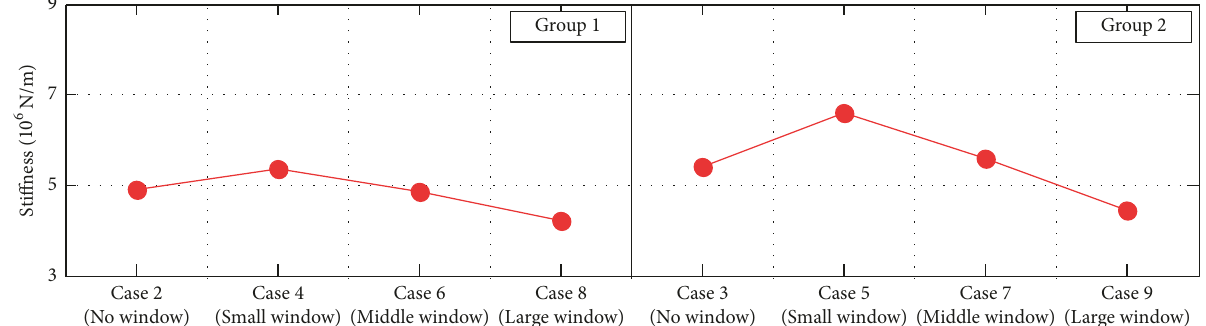
Figure 18: Effect of window glazing systems on lateral stiffness.